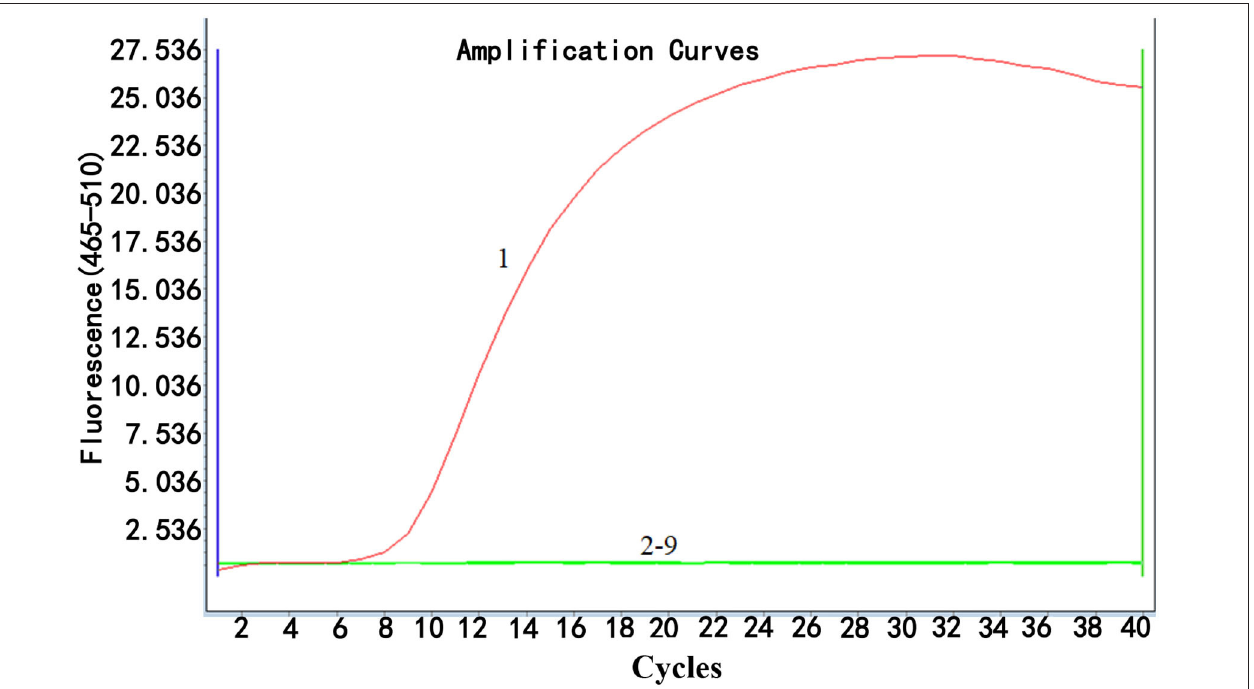
FIGURE 3 | Specificity analysis of real-time RPA assay. Only DNA from ALV-J infected samples was positively amplified (curve 1), while no amplification of other DNA or RNA viruses (cDNA) (curves 2–9 were from the following viruses: ALV-A, ALV-B, ALV-D, ALV-K, IBDV, ILTV, IBV, NDV, and H9, respectively) was observed. Nuclease-free water was used for curve N as a negative control. The results suggested that the developed real-time RPA assay was highly specific. Reactions were scored positive when the change in fluorescence exceeded 1.0